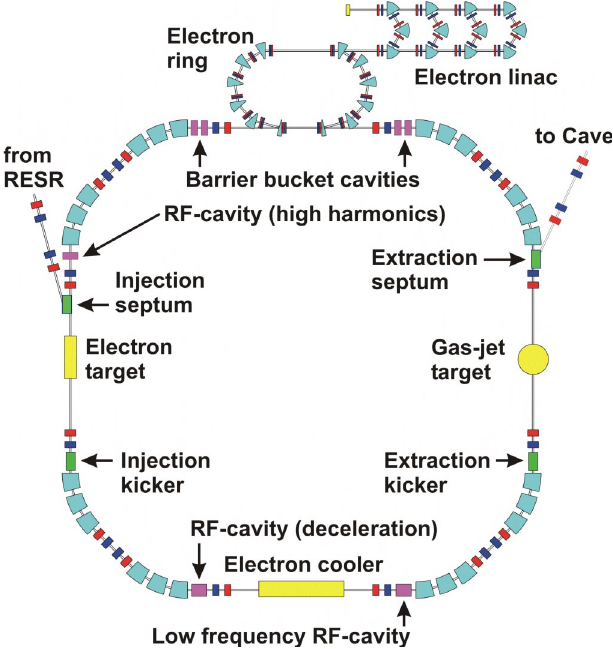
FIG. 2. (Color) General layout of the NESR storage ring.